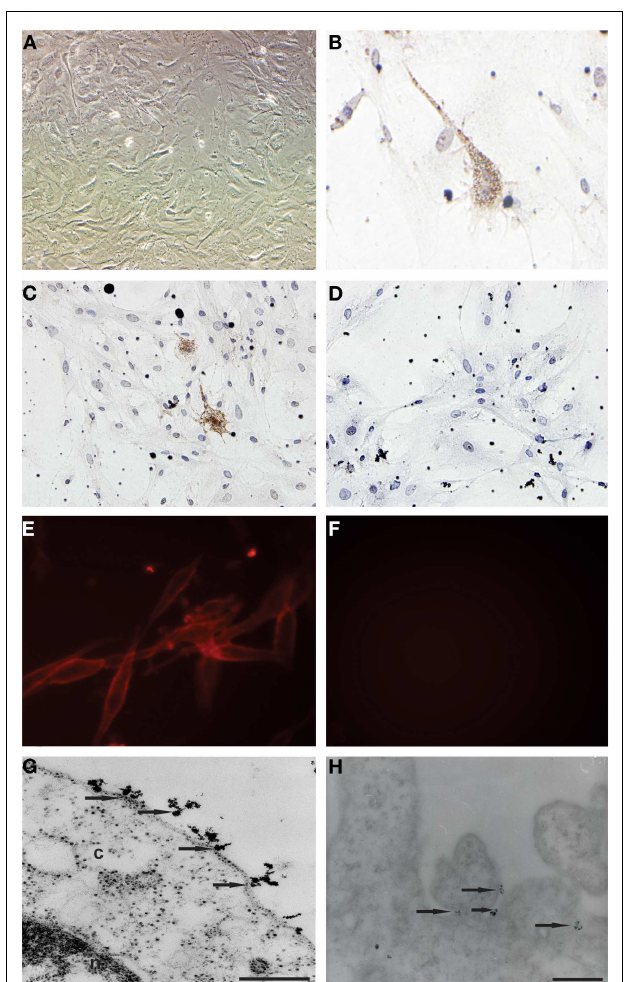
FIGURE 2 | Isolation of tumor neurospheres derived from glioblastoma primary culture and derived straight from the tumor . (A,C,E,G) Glioblastoma neurospheres culture derived from fresh tumor. (B,D,F,H) Glioblastoma neurospheres culture derived from tumor primary culture. Representative figure of five samples of glioblastoma. (A,B) Magnification: 100 × , (C) magnification: 200 × , (D–H) magnification: 600 × . cacodylate buffer for 2 h at 4°C. Cells were washed in cacodylate buffer,2 times for 15 min each. Post-fixation was performed in 1% osmium tetroxide for 1 h at 4°C, followed by another two washes in the same buffer. For contrast, the pellet was immersed in a solution of uranyl acetate in acetone for 30 min. After dehydra- tion, the material was embedded in Epon resin diluted in acetone (1:1) and incubated at 4°C with agitation for 24 h. The pellet was then transferred to pure Epon resin and incubated at 60°C for 72 h, until completely polymerized. Semi and ultrathin sections wereobtainedthroughPorterBlumultramicrotome.Thesemithin sections were stained with azur II (1%) and methylene blue